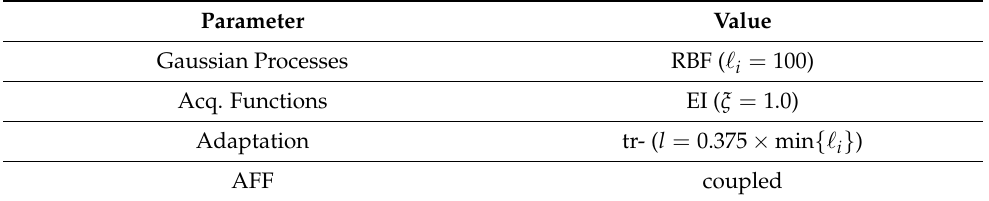
Table 5. MEBO-proposed approach